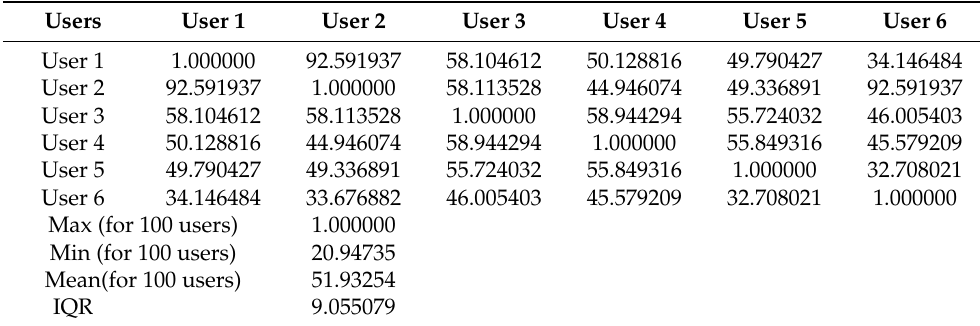
Table 9. The Enhanced Similarity